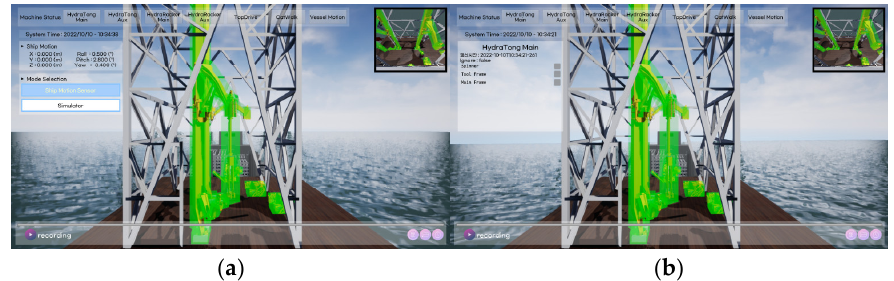
Figure 9. An example of using the machine status bar. ( a ) shows vessel motion information when the ‘Vessel Motion’ item is selected. ( b ) indicates the subsystems of the machine when the ‘Hydratong Main’ item is selected.